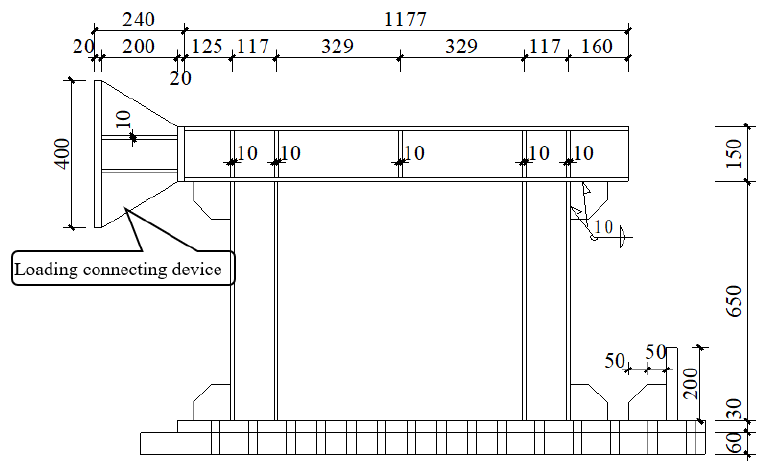
Figure 1. Elevation of specimen 1 (units: mm).